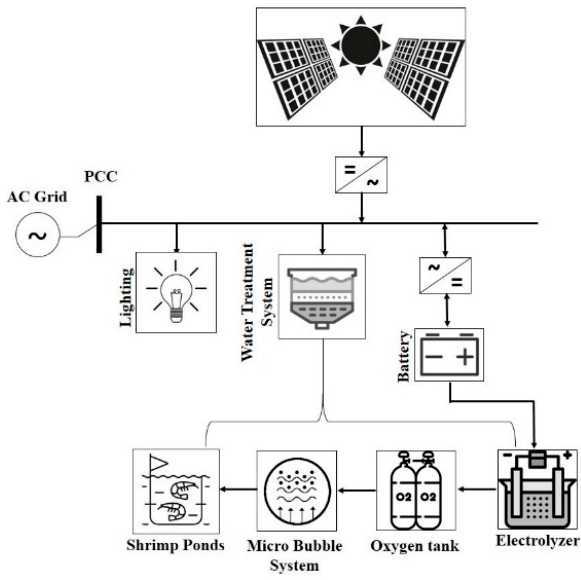
Figure 3. Solar-Energy-based model configuration for shrimp farms.